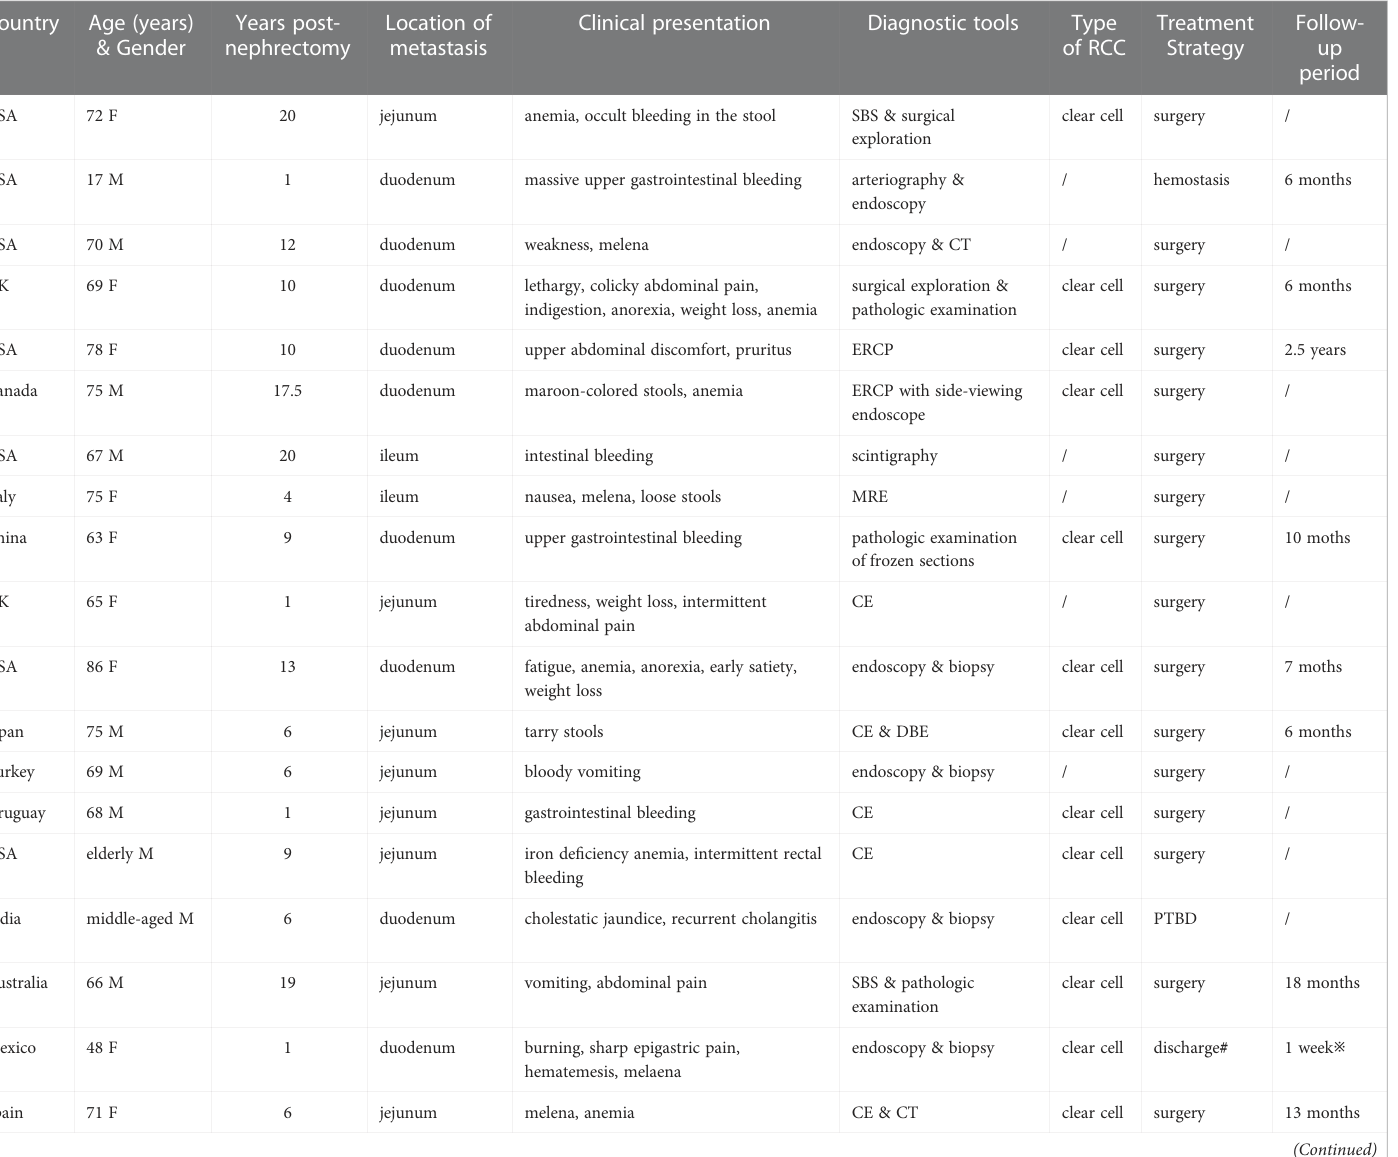
TABLE 1 General characteristics of the reported cases of solitary metachronous small bowel metastasis from